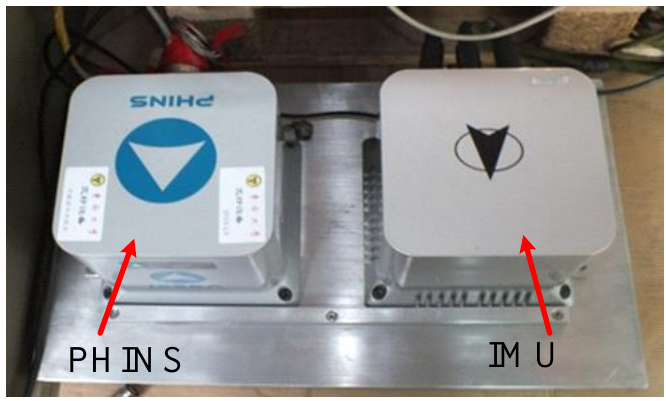
Figure 5. Installation method of the fiber optic gyro inertial system (FOSN) and the high-precision fiber optic gyro SINS (PHINS). Sensors 2017 , 17 , 1424